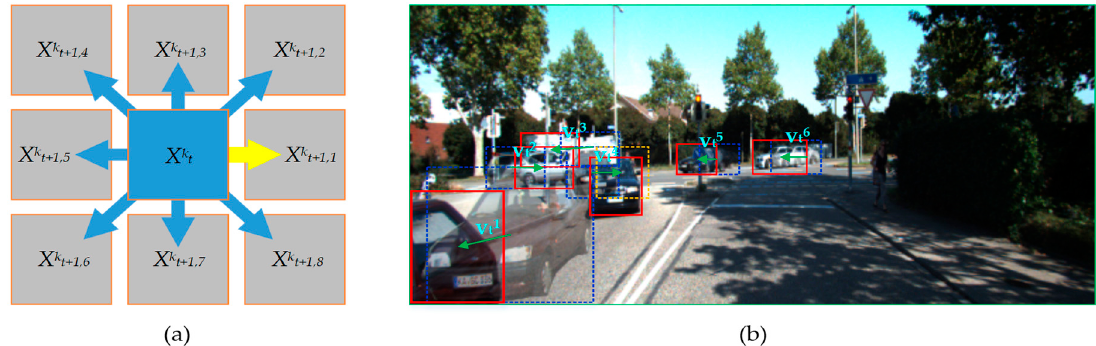
Figure 5. ( a ) Spatial positions of the relative predicted candidates at frame t + 1; ( b ) example of the response of the same target’s candidate to the motion model at different frames.